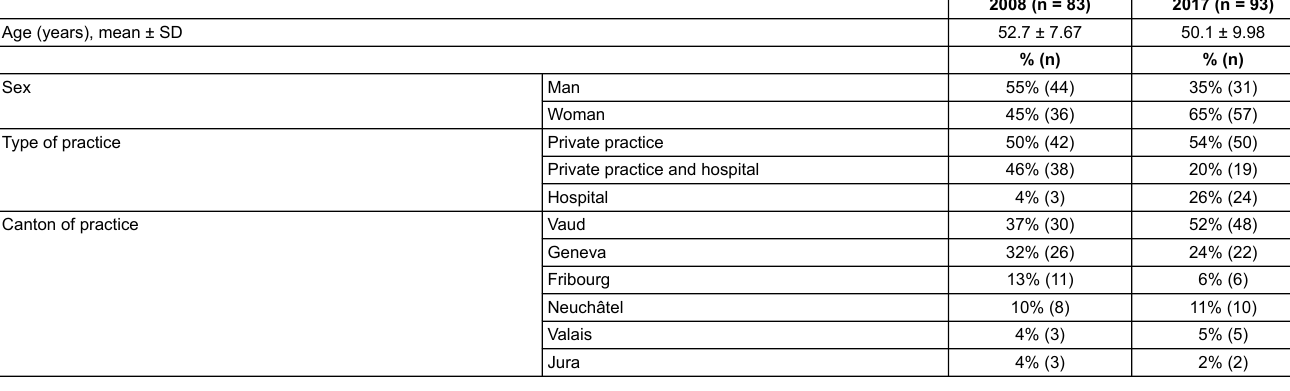
Table 5: Description of the gynaecologists-obstetricians study population in 2008 and 2017